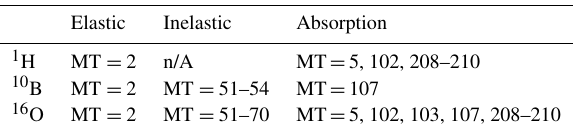
Table 1. Example cross sections according to the ENDF